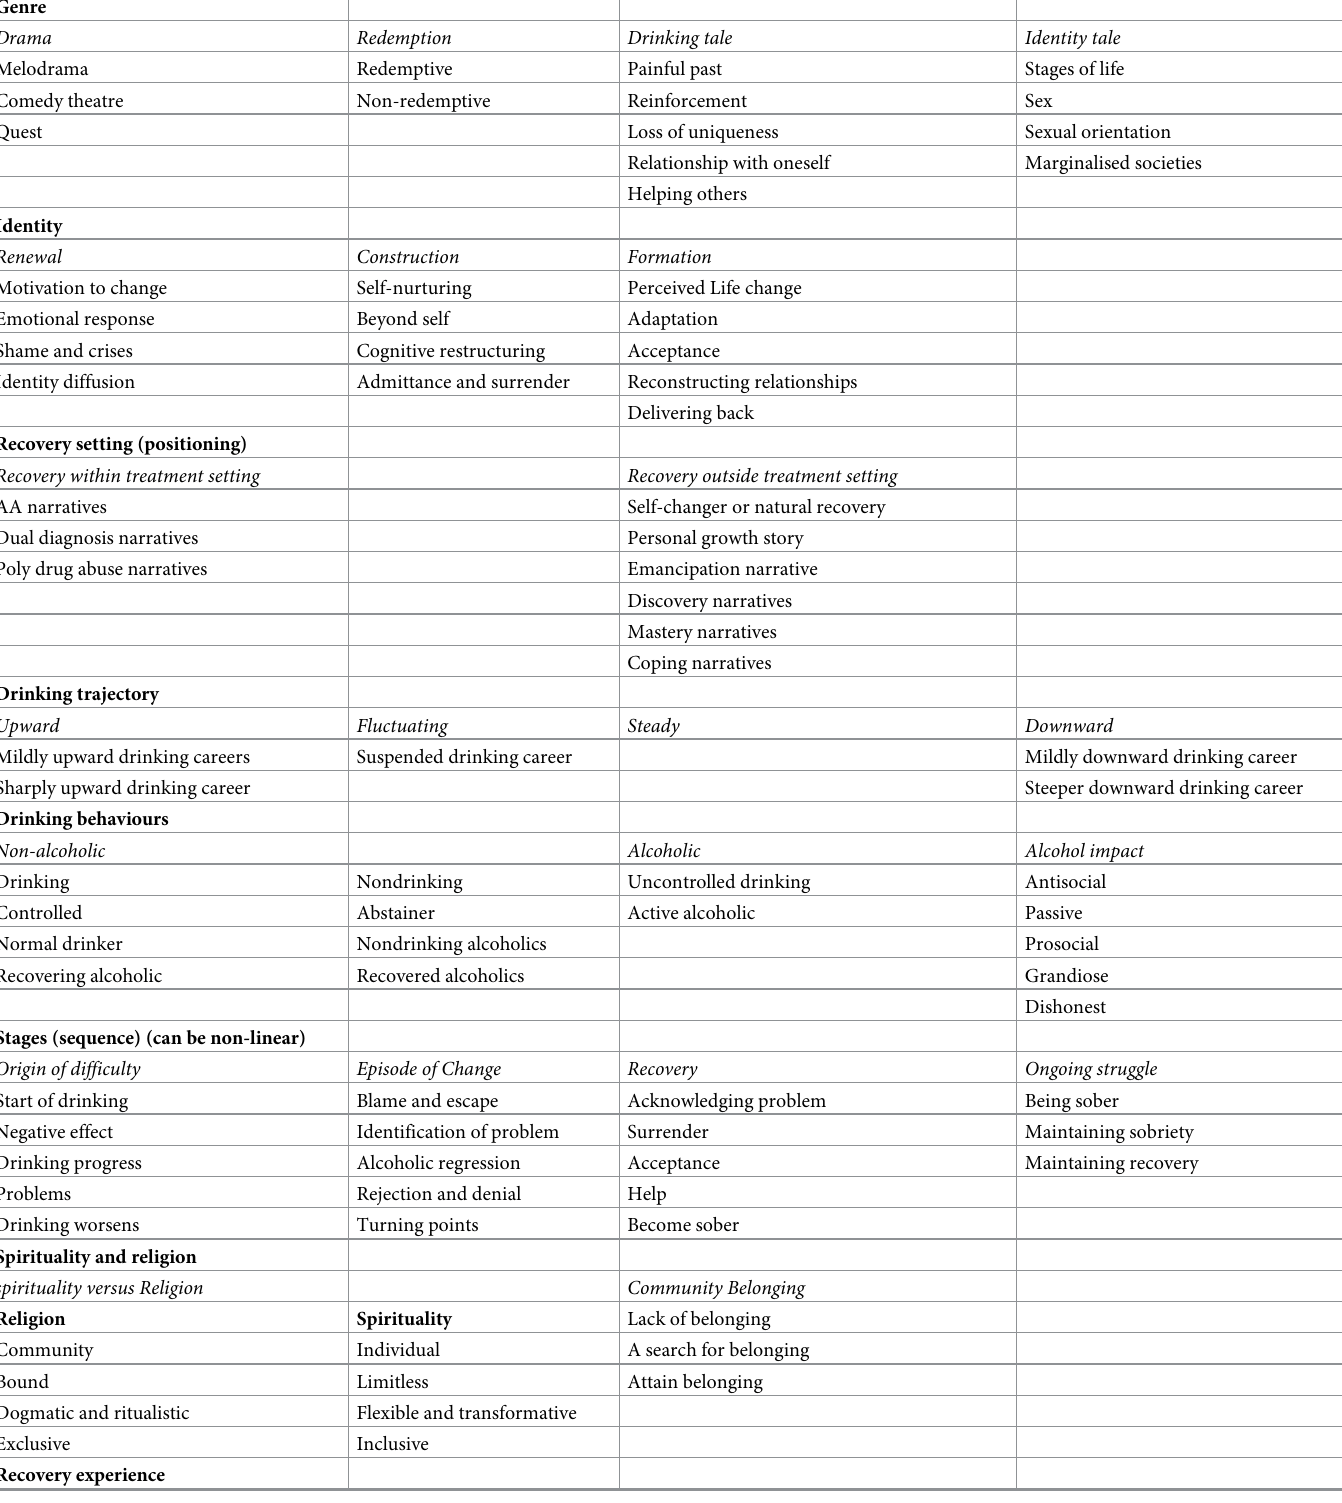
Table 3. Description of types and subtypes of alcohol recovery stories